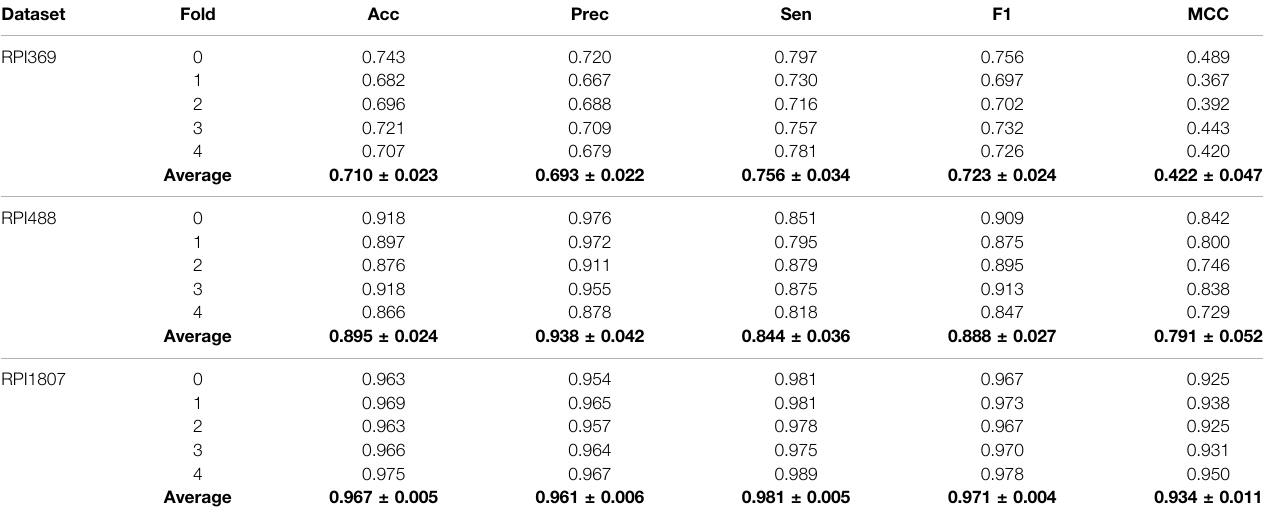
Table 3 | Five-Fold cross-validation results on three datasets by SAWRPI.